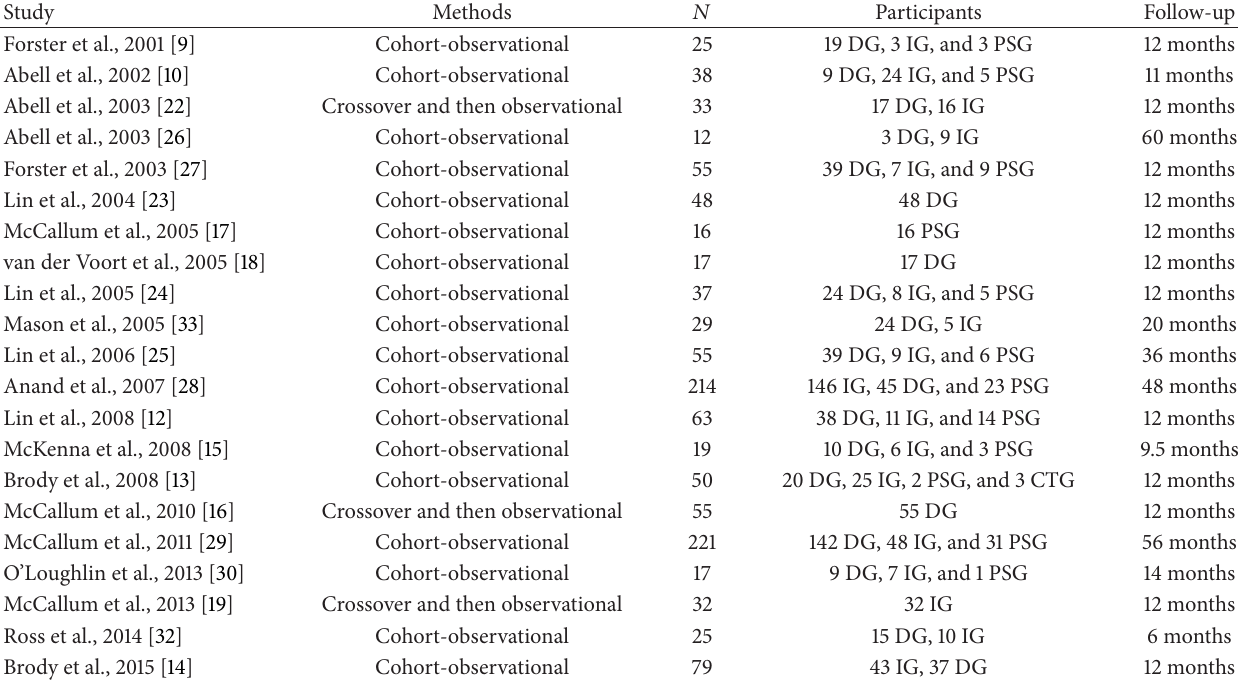
Table 1: Summary of